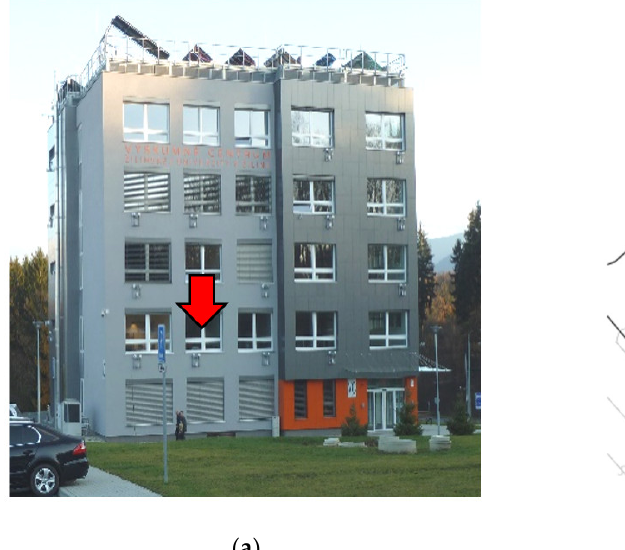
Figure 1. ( a ) West-side view of the Research Center building with red arrow indicating measured office; ( b ) floor-plan with red rectangle indicates measured office. Table 1. Summary table of building passive house characteristics.